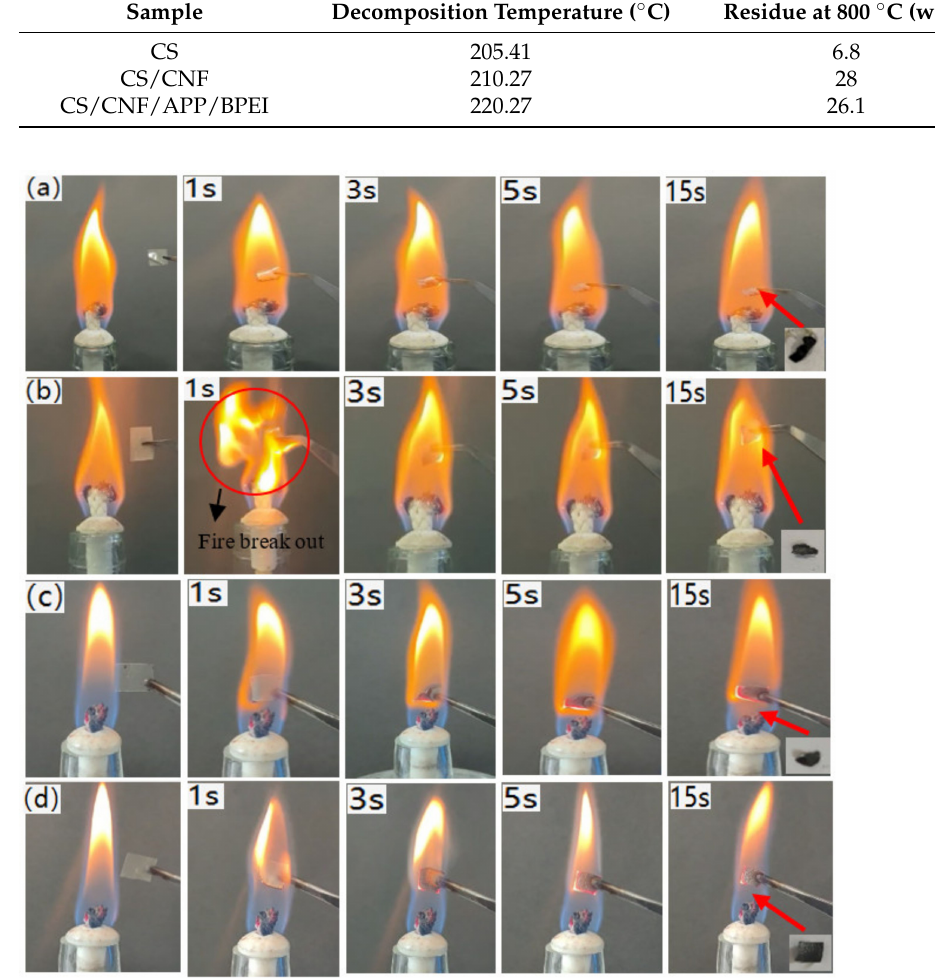
Figure 5. Flame burning test of the ( a ) CS film; ( b ) CS/CNF film; ( c ) CS/APP/BEPI film; ( d ) CS/ CNF/APP/BEPI